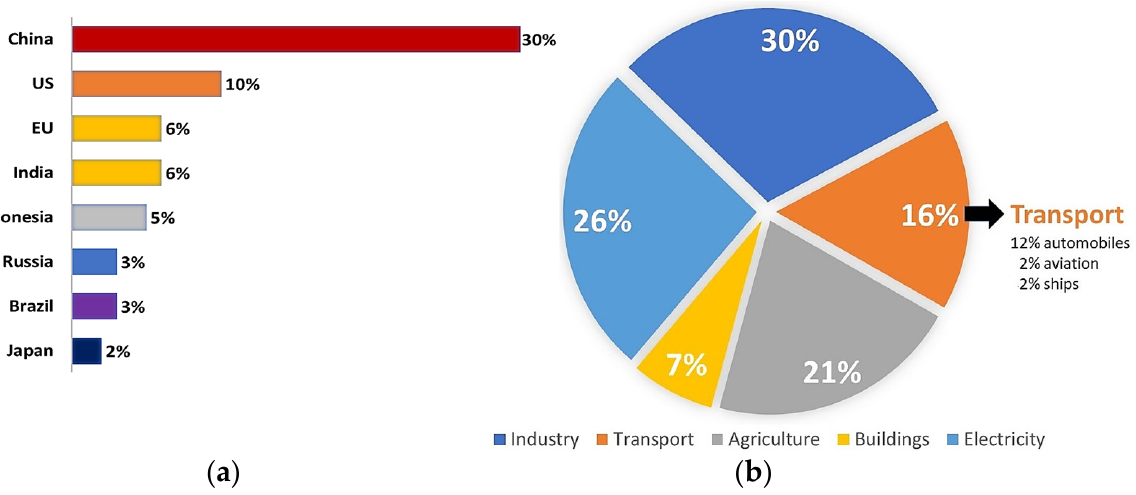
Figure 1. GHG emissions contributions + (2020). ( a ) Country-wise. ( b ) Sector-wise. + Data collected from Rhodium Group official webpage [1].